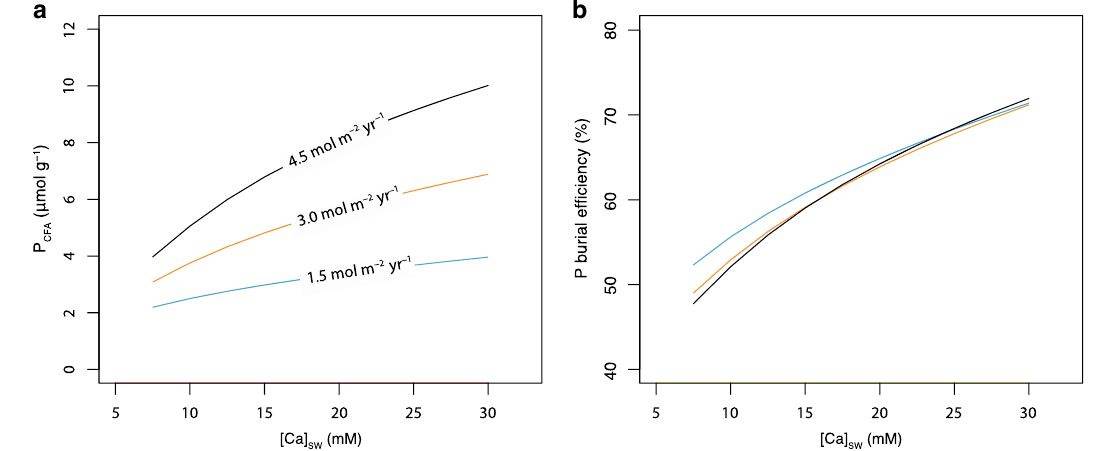
Fig. 1 Diagenetic model of seawater Ca in fl uence on CFA and P burial. P CFA represents burial concentration of CFA-associated phosphorus in marine sediments. a – b The effects of seawater dissolved calcium concentration ([Ca] SW ) upon P CFA and P burial ef fi ciency. Labeled fl uxes indicate rates of organic matter loading at the sediment – seawater interface.